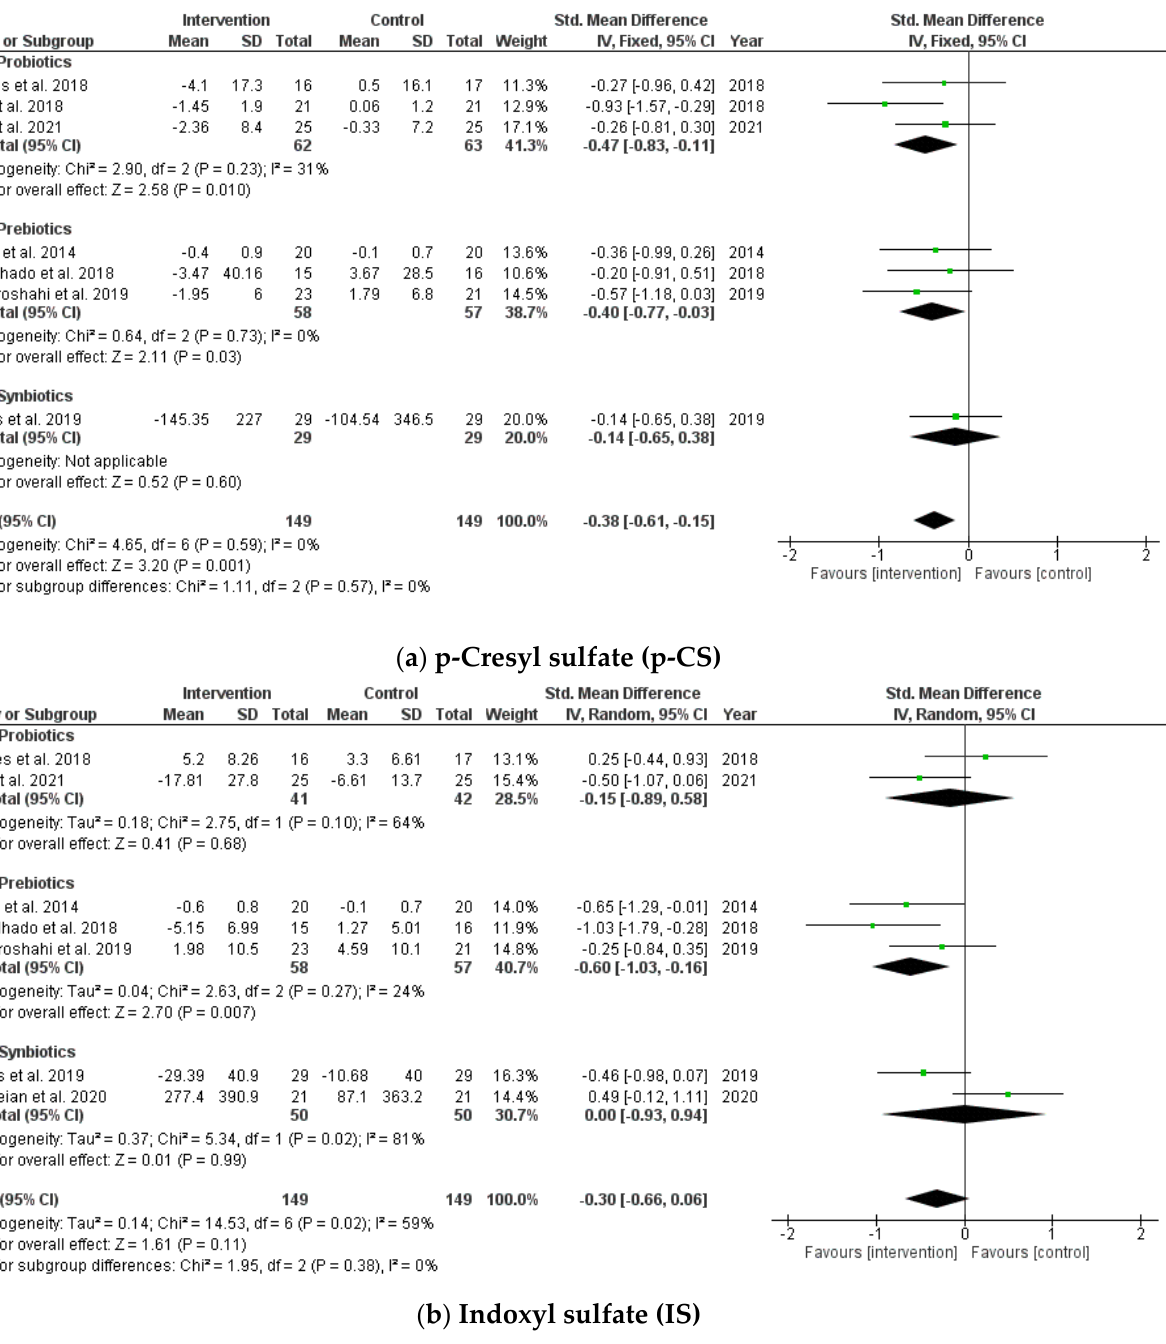
Figure 3. Forest plot for probiotic, prebiotic, and synbiotic effects on ( a ) p-cresyl sulfate (p-CS) and ( b ) indoxyl sulfate (IS) in hemodialysis patients.